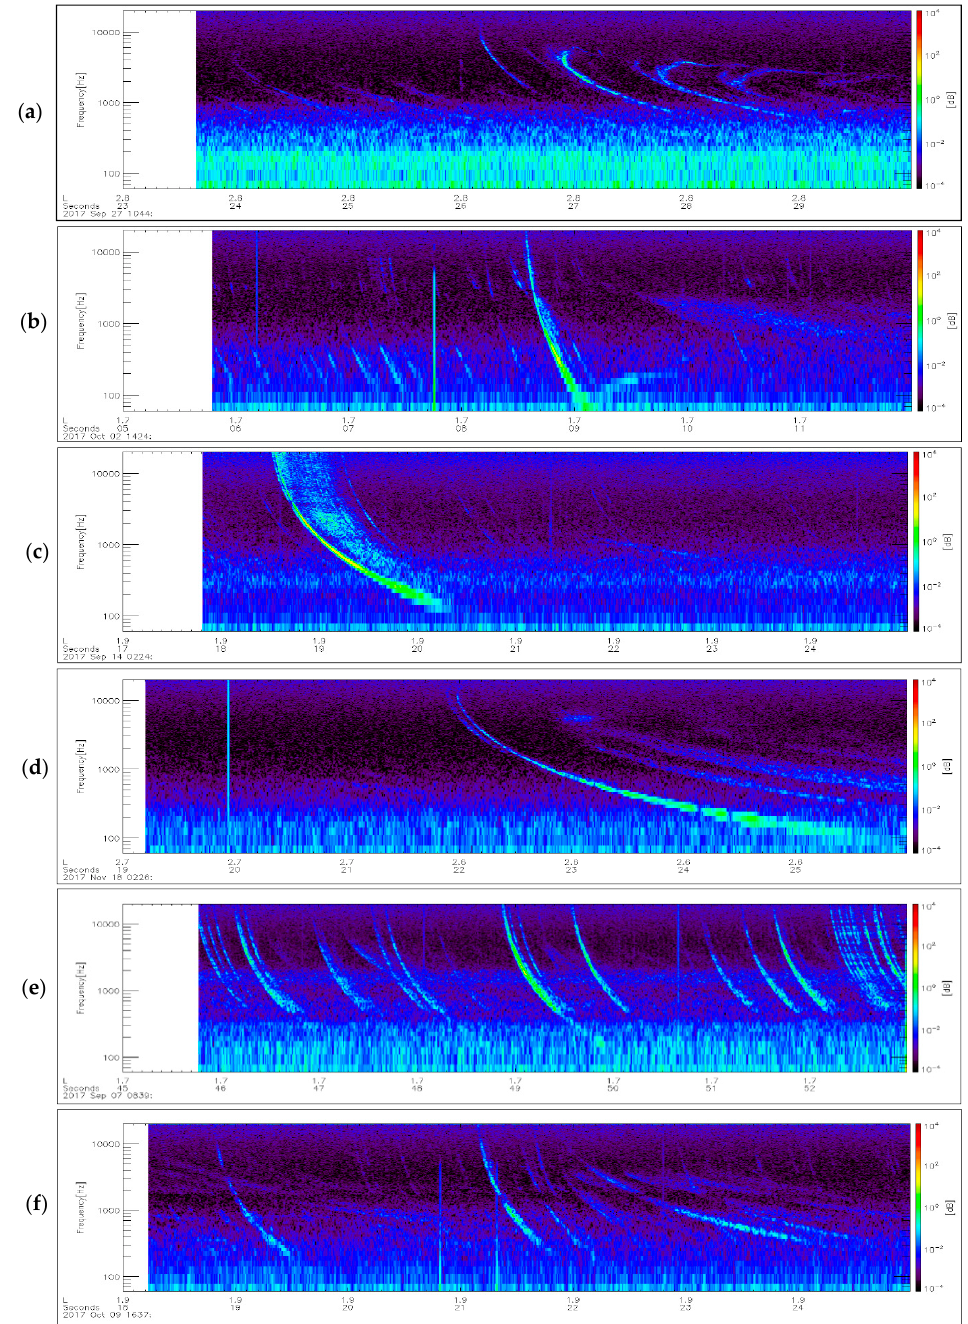
Figure 3. ( a ) Nose whistler at 10:44:27 UT on 27 September 2017; ( b ) short whistler at 14:24:08 UT on 2 October 2017; ( c ) middle whistler at 02:24:18 UT on 14 September 2017; ( d ) long whistler at 02:26:22 UT on November 18, 2017; ( e ) multiple-traces at 08:39:45 UT on 7 September 2017; ( f ) multiple-combinations at 16:37:18 UT on 9 October 2017, observed by the PWE / WFC (plasma wave experiment / waveform